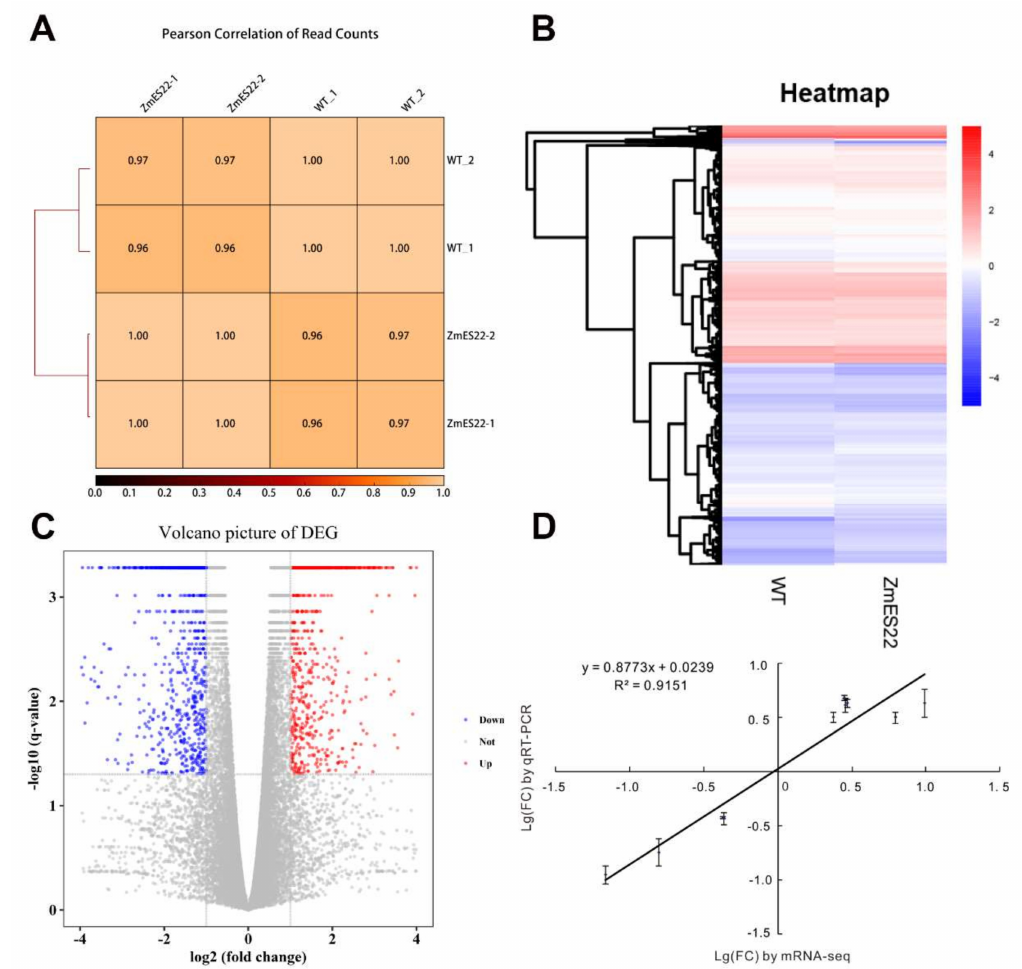
Figure 8. RNA-seq analysis of endosperm at 20 DAP for transgenic rice lines and wild-type plants. ( A ) Pearson correlation of read counts. ( B ) Heat map comparison between Zhonghua 11 and L9. ( C ) A volcano plot of differentially expressed genes (DEGs) about Zhonghua 11 and L9. ( D ) Validation of transcription group data. Expression level changes (log2 (fold change)) of 10 randomly selected DEGs analyzed by RNA-Seq ( x -axis) were compared with expression data obtained by qRT-PCR ( y